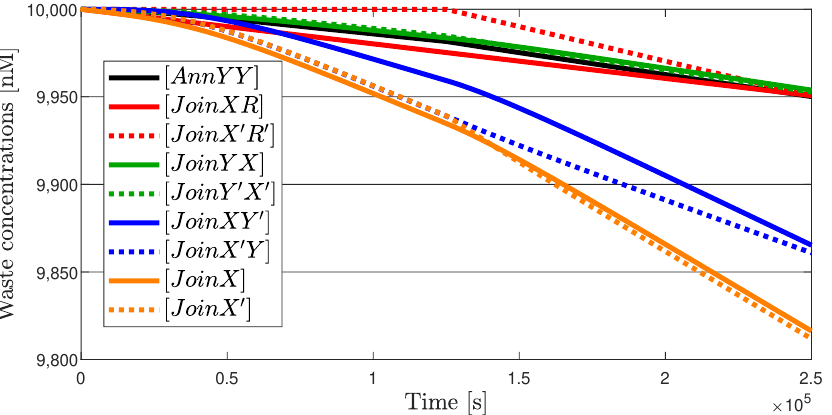
Figure 17. Histories of the consumptions of the auxiliary species from the simulation in Visual DSD of the state feedback control in Example 4, with concentrations remaining close to their initial value of C max = 10 4 nM throughout the operation of the circuit.